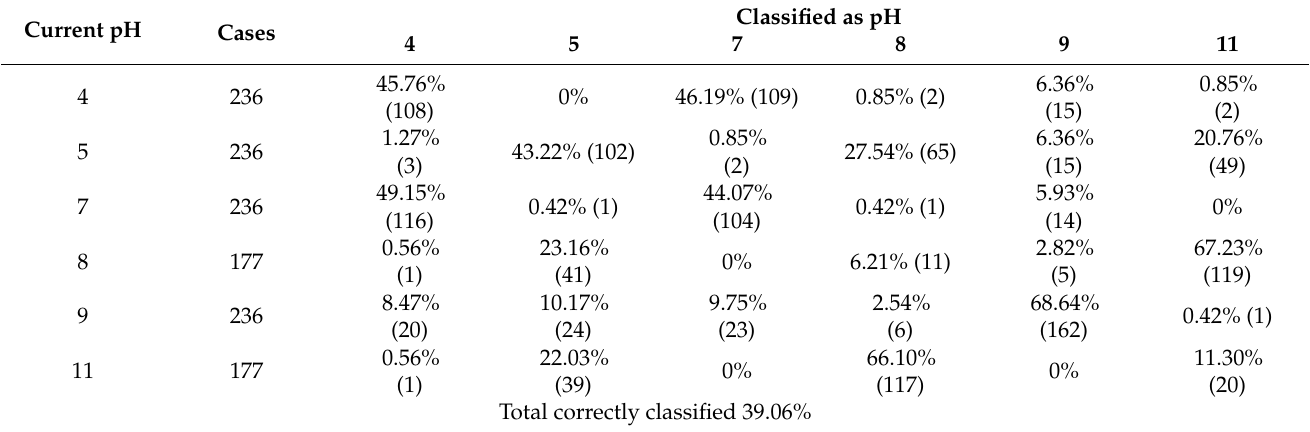
Table 9. Classification results of PNN using all cases and temperature, frequency, Vpp, and delay as input neurons.